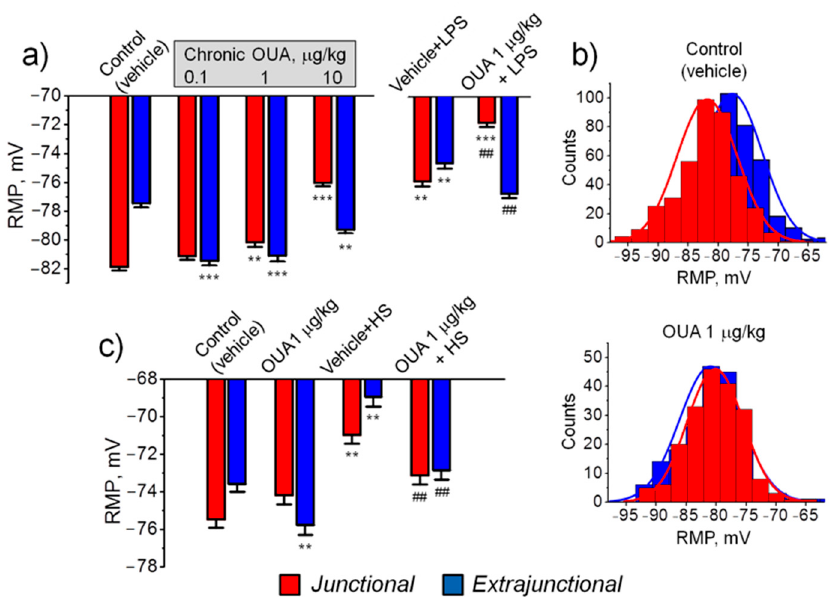
Figure 2. Effects of chronic ouabain (OUA) administration on the resting membrane potential (RMP) of rat diaphragm ( a, b ) and soleus ( c ) muscles. Rats were intraperitoneally injected with different doses of ouabain (µg/kg, as indicated) for 4 days. ( a ) Treatment with ouabain alone or with subsequent LPS (1 mg/kg) administration (see Methods). ( b ) The distributions of RMP in control and ouabain (1 µg/kg) treated muscles; the same data as in ( a ). ( c ) Treatment by ouabain (1 µg/kg) alone or with subsequent 6 h of hindlimb suspension (HS) (see Methods). The RMP reported in each data point represents the mean of measurements in at least 100 fibers from 4–6 diaphragm muscles and in at least 120 fibers from 6–8 soleus muscles. ** p < 0.01 and *** p < 0.001 compared with the corresponding control (vehicle treated group); ## p < 0.01 compared with LPS- or HS-treated groups. Red – junctional; blue – extrajunctional membrane regions.